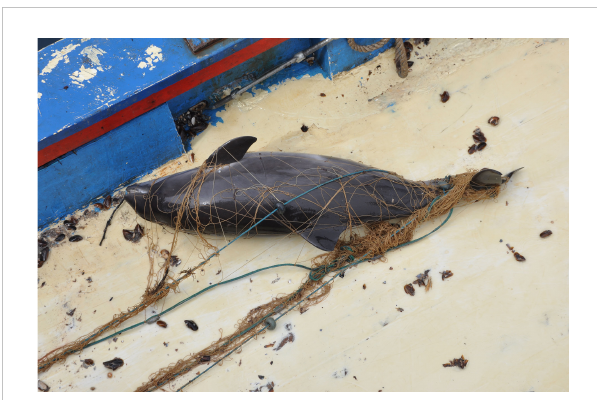
FIGURE 2 Bycaught Black Sea bottlenose